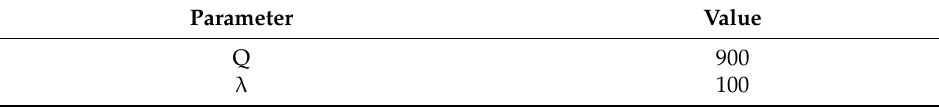
Table 5. Sliding Mode Controller